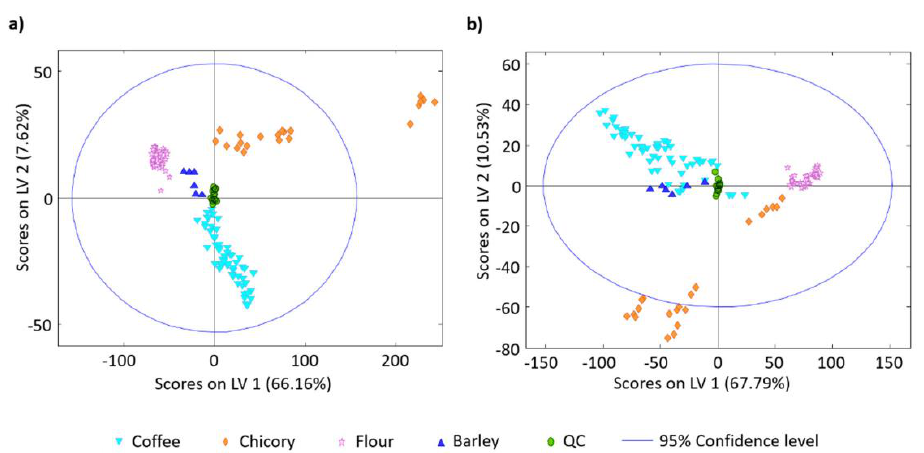
Figure 9. PLS-DA classification of the samples using HPLC-UV/VIS ( a ) and HPLC-FLD ( b ) finger- prints [151].